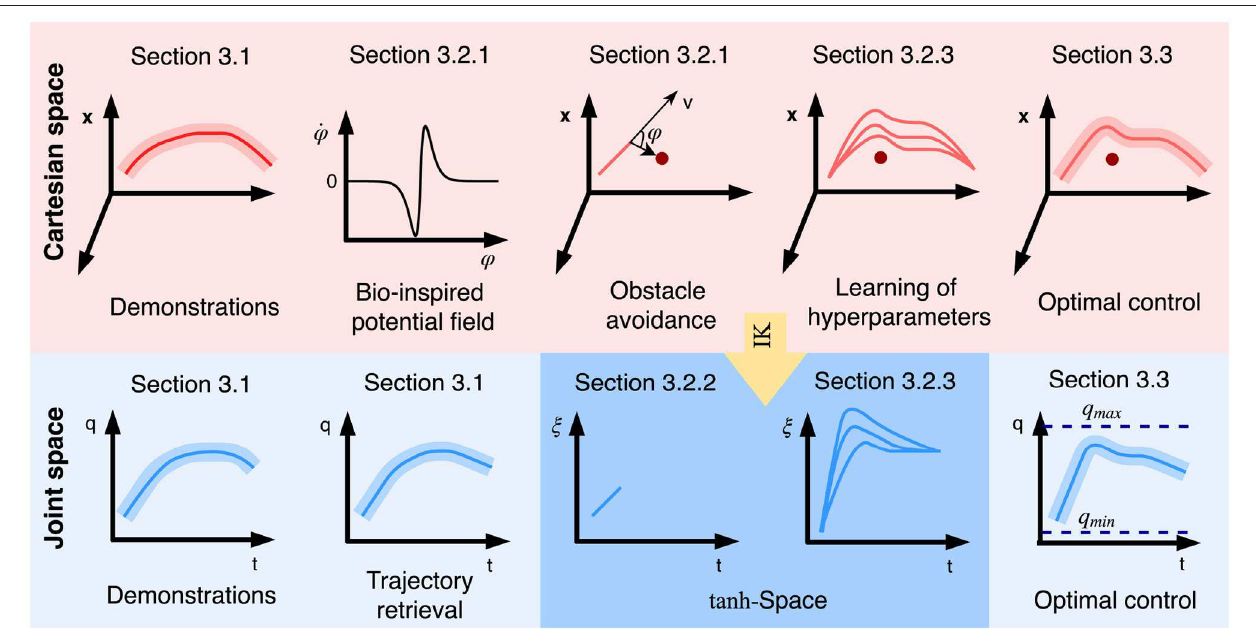
FIGURE 1 | Illustration of the proposed approach to obstacle avoidance within hybrid imitation learning. First, multiple demonstrations are presented to the robot and the statistical information are encoded by GMR. Subsequently, with the help of Gaussian product between Cartesian trajectory and joint trajectory, the inconsistency from both spaces are unified. A bio-inspired potential field is employed for obstacle avoidance, since it can better reserve the fidelity against the original trajectory. The hyperparameters of the potential field are determined by reinforcement learning with the learned trajectory driven by a minimal intervention